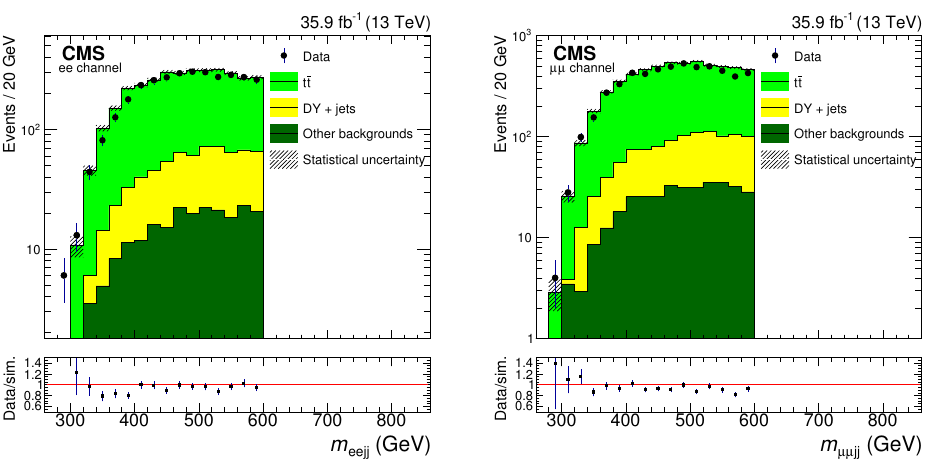
Figure 2 . The m ‘‘ jj distribution in the low m ‘‘ jj control region with the DY SF applied for the electron (left) and muon (right) channel. The uncertainty bands on the simulated background histograms include only statistical uncertainties. The uncertainty bars in the ratio plots represent combined statistical uncertainties of data and simulation.